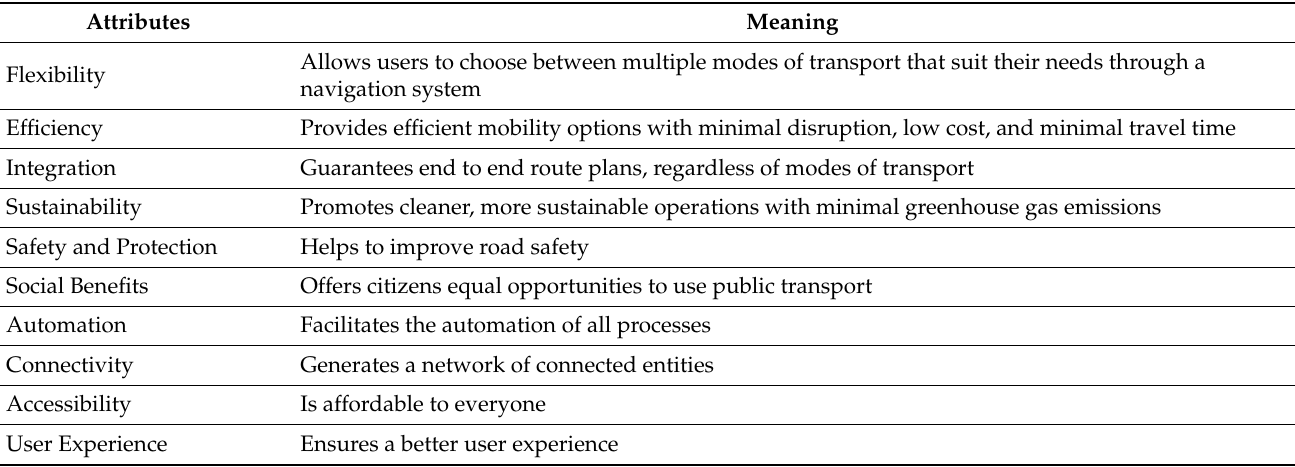
Table 1. Attributes and meanings of Smart